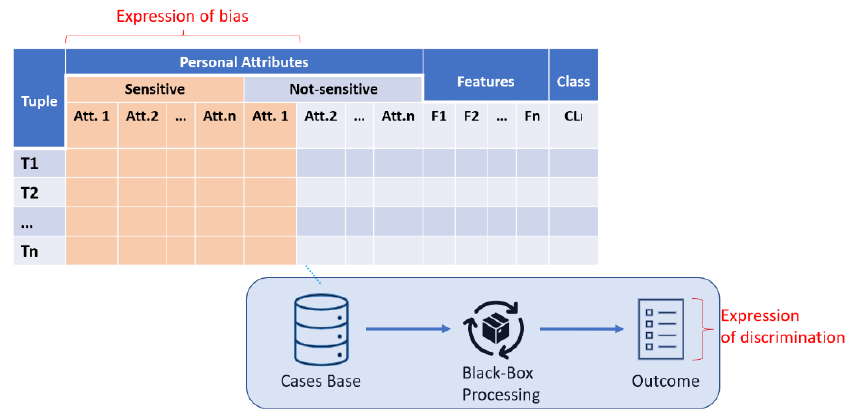
Figure 1. Simplified representation of an automated decision-making process.